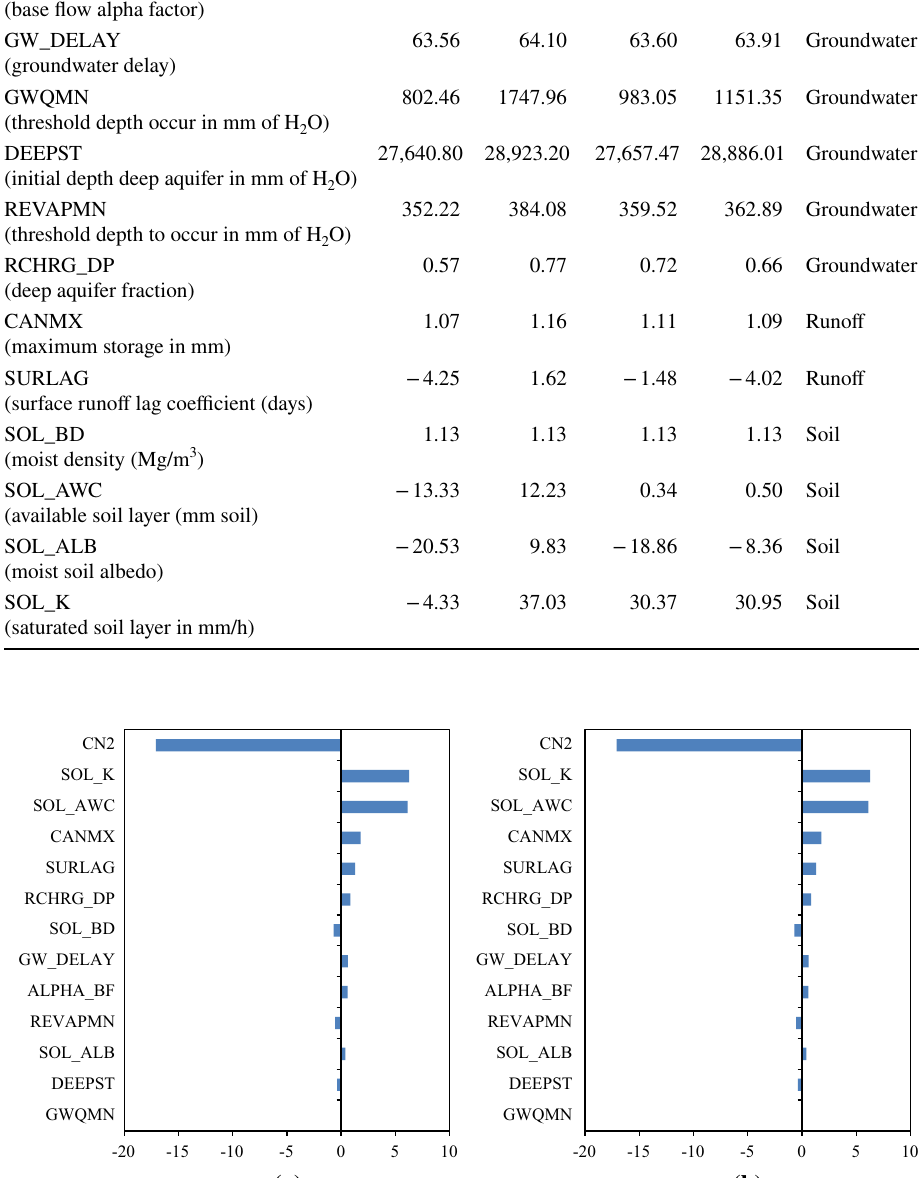
Table 1 Calibrated values of sensitive hydrologic parameters at two gauging stations in the Gomti river basin